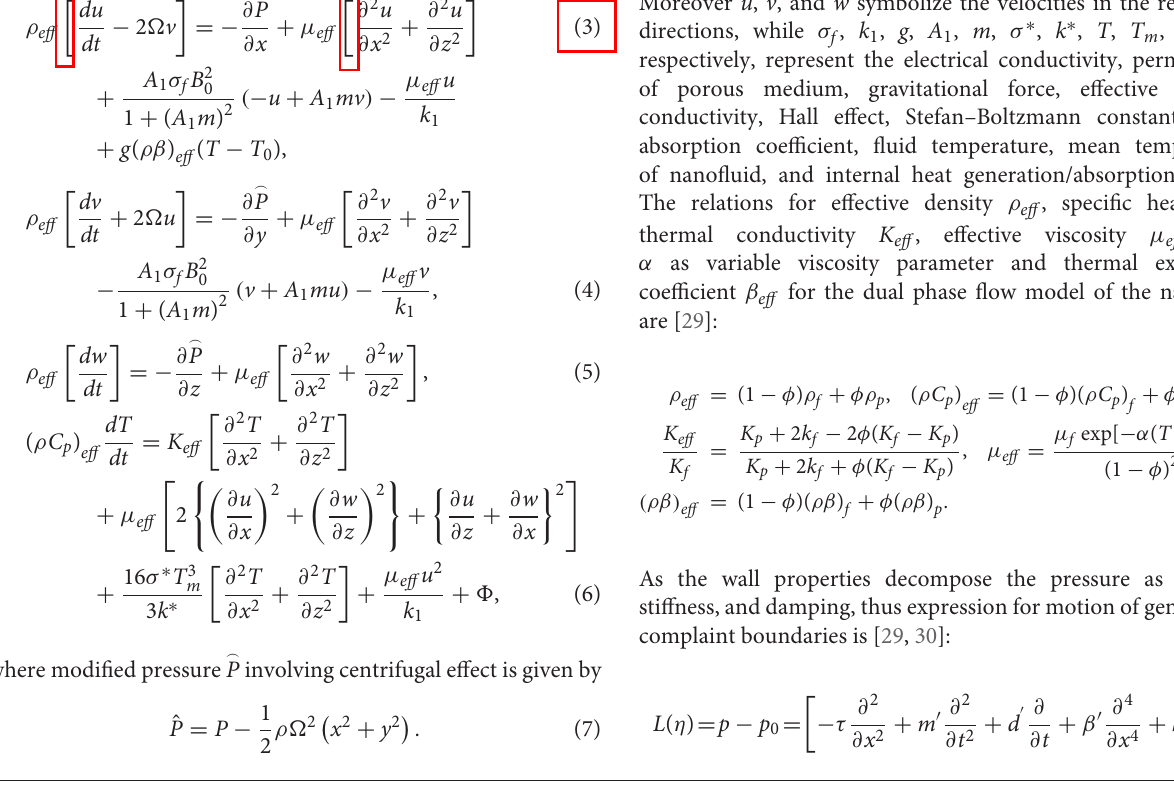
Frontiers in Physics |